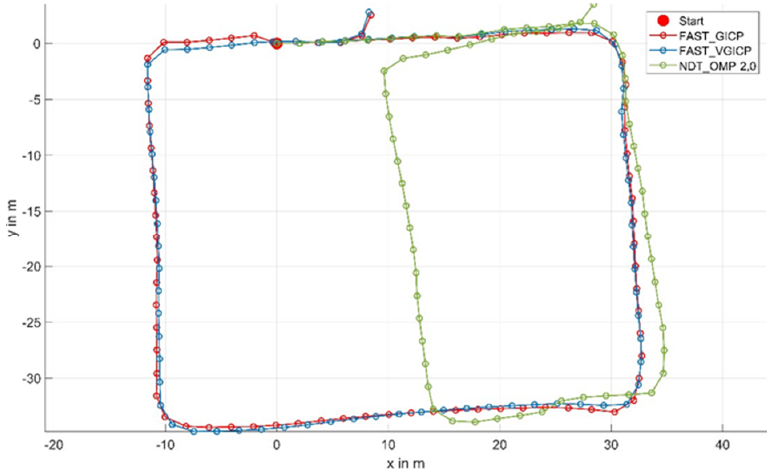
Figure 9. Trajectories of the hdl_graph_slam in the corridor of the B-building of the Offenburg Uni- versity of Applied Sciences. University of Applied Sciences.